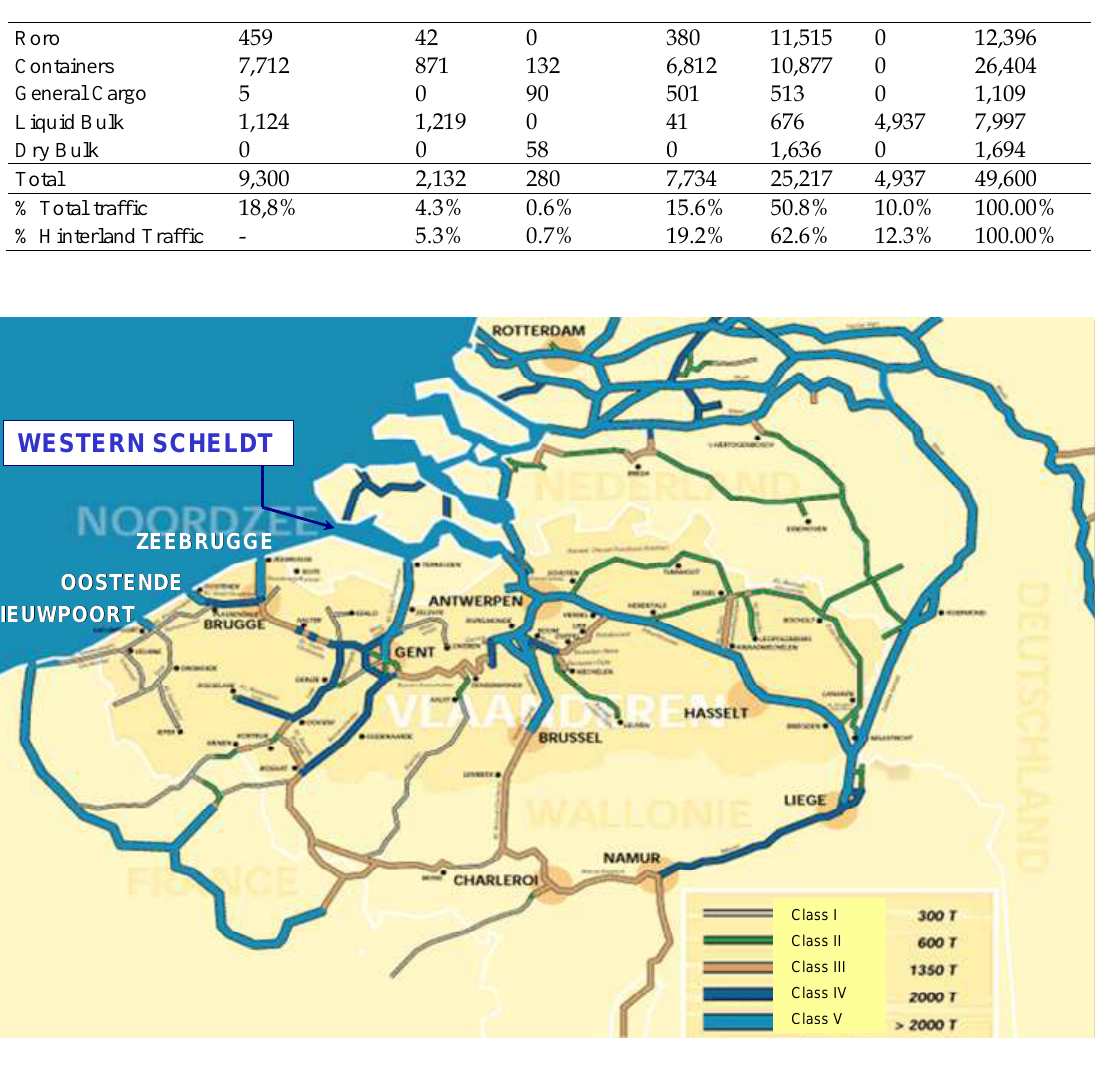
Figure 1. Location of Belgian coastal harbours and inland waterways network. Source: adapted from Promotie Binnenvaart